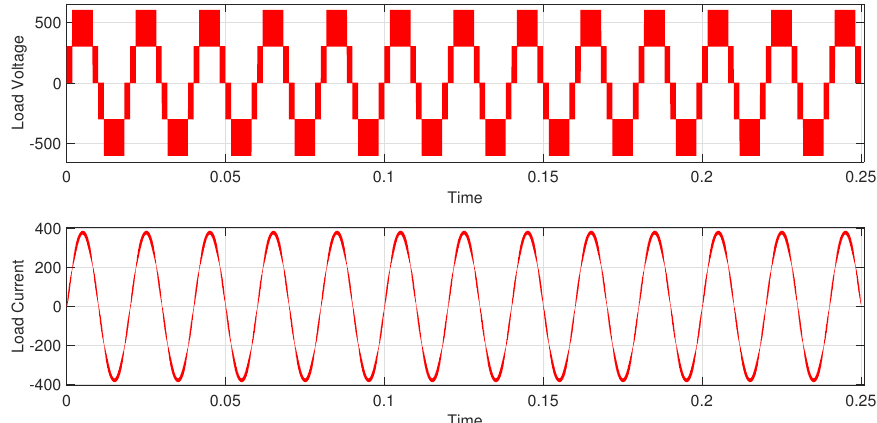
Figure 9. The single-phase output voltage and current of 5-level CHB inverter. In the waveforms of the single-phase version of the proposed conditioner, the output voltage has a five-level stepped configuration and the current is shaped as an almost-pure sinusoidal signal, which is a desired result in order to effectively drive an asynchronous induction coil launcher. The analog implementation of the three-phase version of the proposed arrangement is also simulated, while the phase-neutral and phase–phase voltage waveforms are demonstrated in Figure 11, and the phase current waveforms are shown in Figure 12. The three-phase simulation results show that the current waveform is smoother than its single-phase counterpart. Furthermore, the step level of the voltage waveforms increased two-fold compared with the single-phase voltage